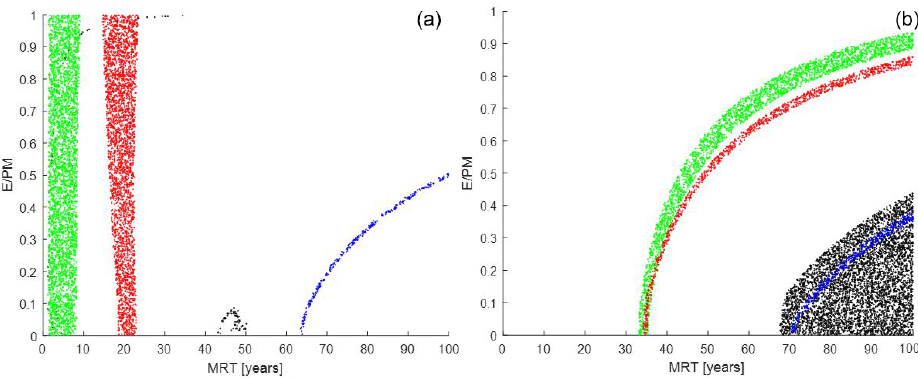
Figure 8. A typical EPM parameter could be inferred with tritium (black), SF 6 (green), Halon-1301 (red) and CFC-113 (blue). In both figures some agreement of age interpretations is evident through overlapping LPM parameter clouds. In the left figure tritium age interpretation is ambiguous; the younger part agrees with the SF 6 and Halon-1301 inferred age. In the right figure the tritium and CFC-113 inferred age agrees, but differs from Halon-1301 and SF 6 inferred ages (which agree with each other).